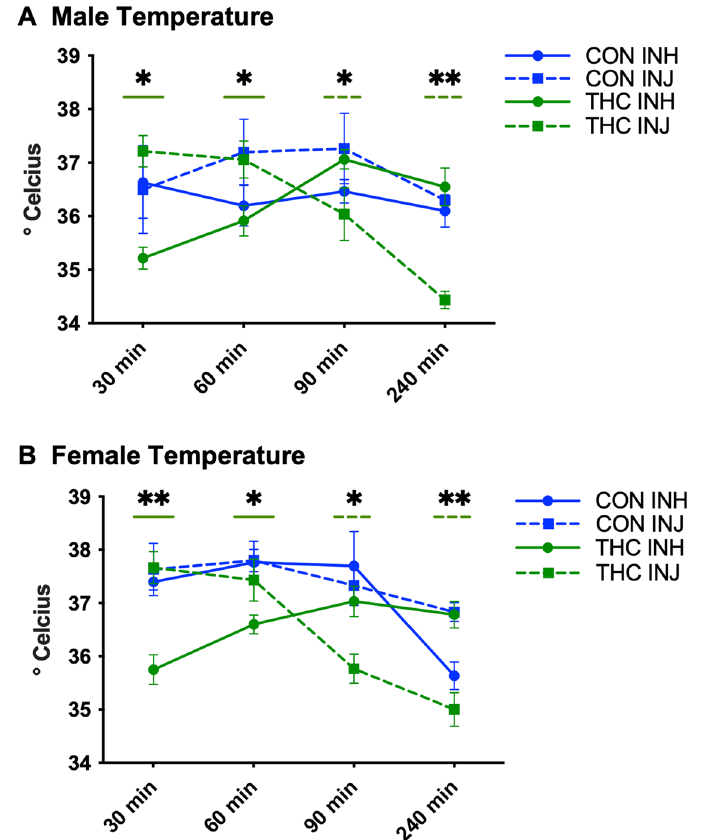
Figure 2. Body temperature. ( A ) Male temperature: Data are presented as mean ± SEM; n = 5–6 for each group. Presence of (*) with a solid and dashed green line indicates that THC-INH and THC-INJ respectively differ from one or more other groups. THC-INH resulted in immediate hypothermia at 30-min (THC-INH < all groups at * p < 0.05) and at 60-min (THC-INH < CON-INJ and THC-INJ at * p < 0.05), whereas THC-INJ resulted in delayed hypothermia at 90-min (THC-INJ < CON-INJ and THC-INH at * p < 0.05) and at 240-min (THC- INJ < all groups at ** p < 0.01). ( B ) Female temperature: data are presented as mean ± SEM; n = 5–6 for each group. Presence of (*) with a solid and dashed green line indicates that THC-INH and THC-INJ respectively differ from one or more other groups. THC-INH resulted in immediate hypothermia at 30-min (THC-INH < all groups at ** p < 0.01) and at 60-min (THC-INH < all groups at * p < 0.05), whereas THC-INJ resulted in delayed hypothermia at 90-min (THC-INJ < all groups at * p < 0.05) and at 240-min (THC-INJ < CON-INJ and THC- INH at ** p <